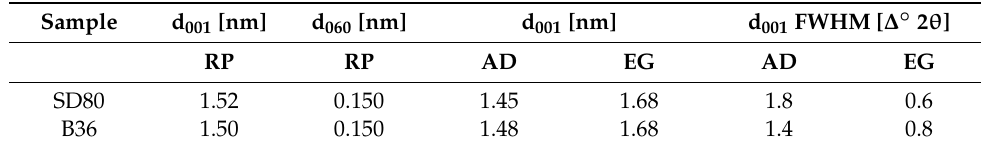
Table 3. XRD parameter of both bentonites. RP: random powder, AD: air dried, EG: ethylene glycol-saturated, FWHM: full-width-at-half-maximum.